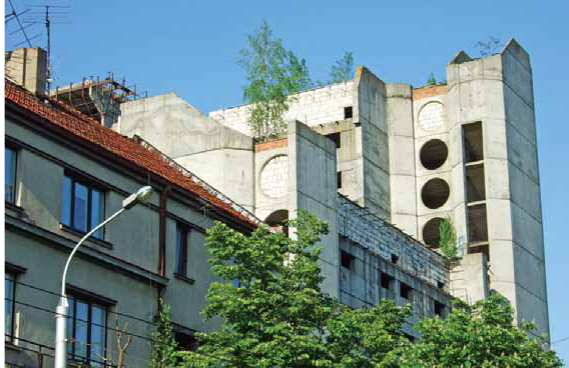
fig. 3. Investors who carry out the conversion of „Tulpe“ building at laisves av. “forgot” to complete the piece above the entry